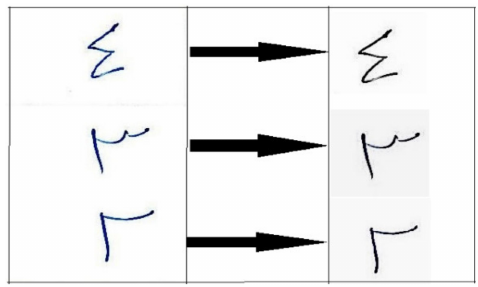
Figure 7. Actual conversion of characters. The grayscale images were converted into binary images. The shades of grayscale images are between gray and white; on the other hand, binary images have only black and white pixels. An image can be converted into binary by making all the pixels above a certain specific threshold value into black, while the remaining is kept white. The binary digit images can be seen in Figure 8.